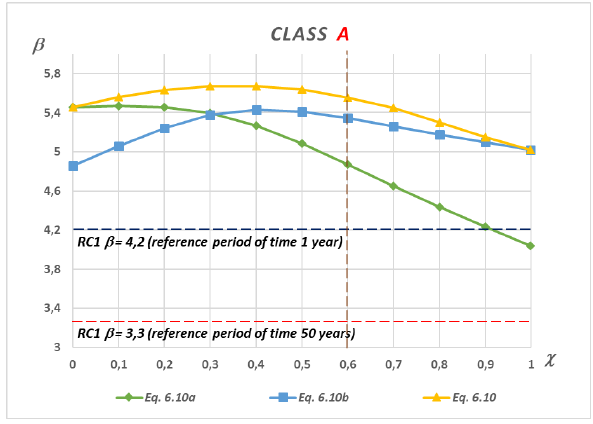
Figure 3: Reliability coeflcient curves β and load factor χ for the class A execution of works and three different combinations of standard coeflcients (formulas: 6.10a, 6.10b, 6.10) - reliability class